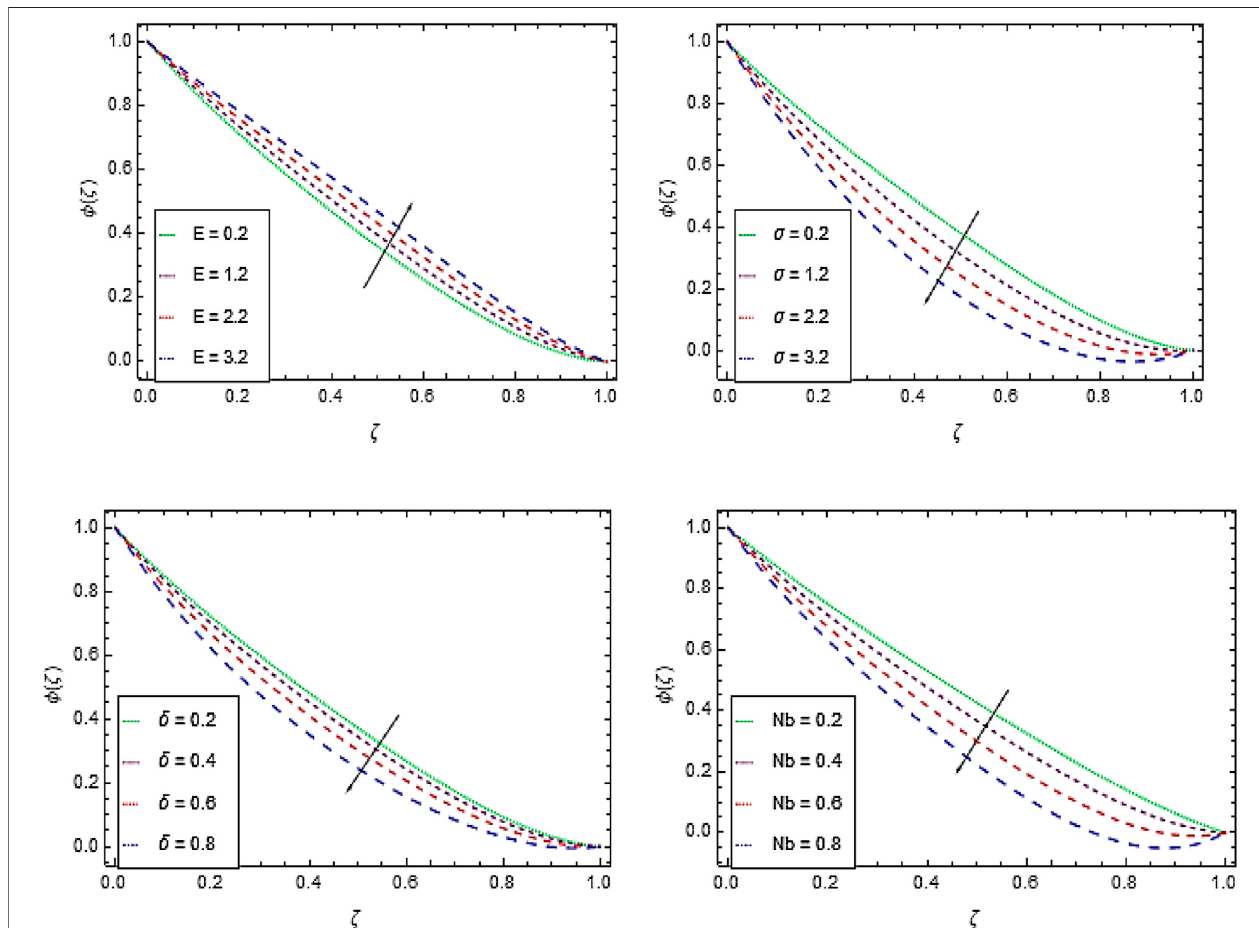
FIGURE 6 | ϕ ( ζ ) as a function of (A) E , (B) σ , (C) δ , and (D) Nb .